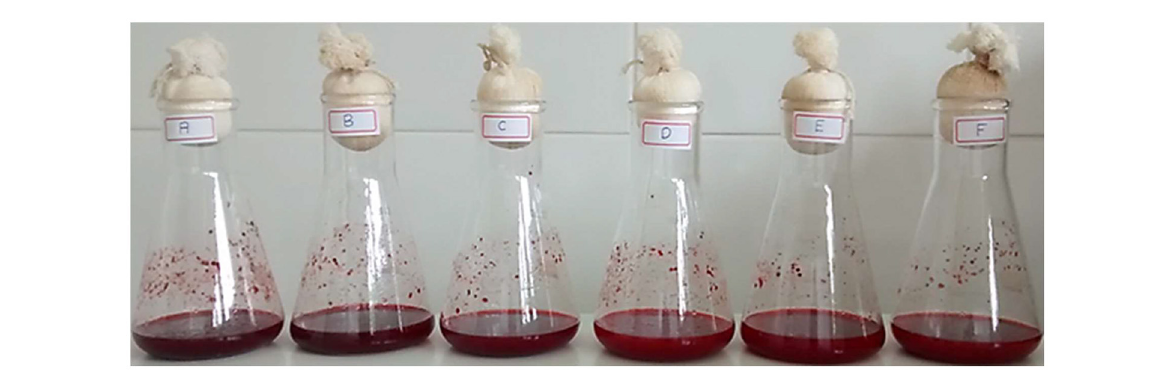
FIGURE5 Pigment production in shaken flasks in 192h of cultivation from Monascus ruber CCT 3802 cultures in shaken flasks in different concentrations of maltose syrup. (A) 20g L − 1 of glucose; (B) 10g L − 1 maltose syrup; (C) 20g L − 1 maltose syrup; (D) 30g L − 1 maltose syrup; (E) 40g L − 1 maltose syrup and (F) 50g L − 1 maltose